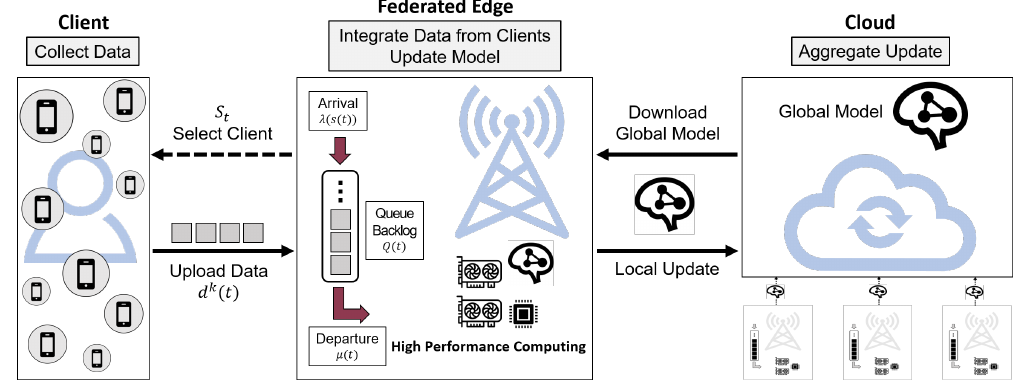
Figure 3. System model of federated learning edge in our proposed